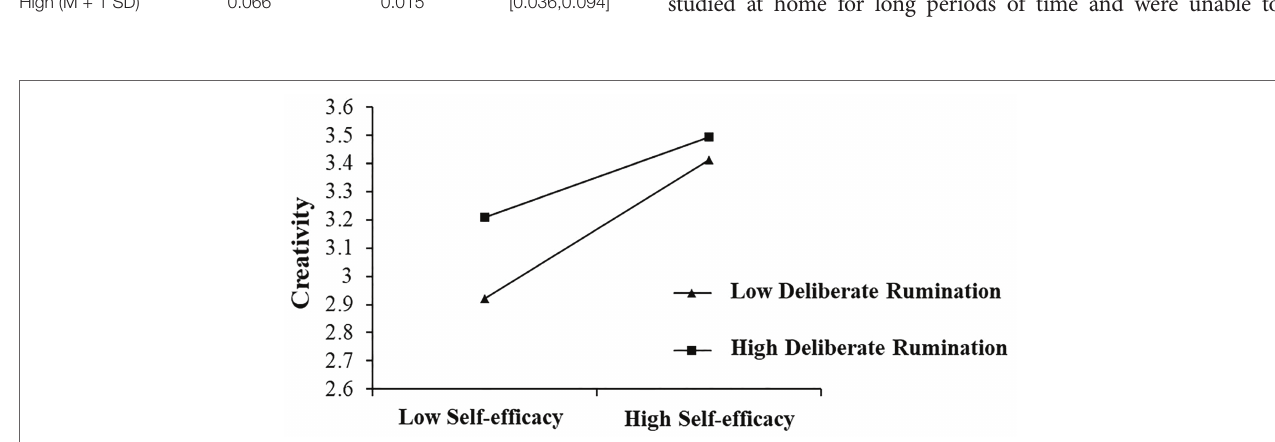
FIGURE 2 | The relationship between self-efficacy and creativity for high and low levels of deliberate